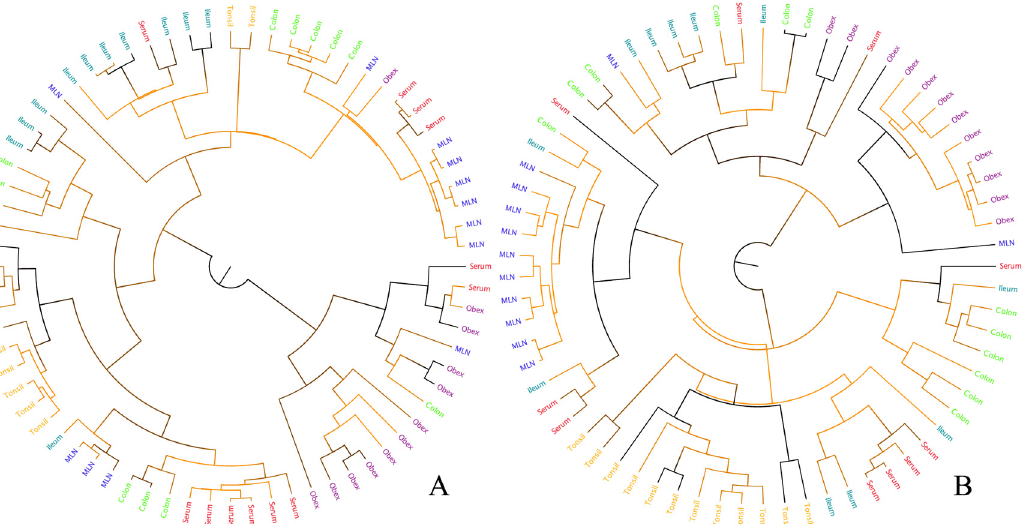
Fig 2. Example phylogenetic tree based on E2 (A) and NS5B (B) gene fragment alignment for PI8. See S2 (E2) and S3 (NS5B) Figs for all other trees. Branches are shaded according to their posterior probability (0 = orange, 1 = black) and the tip labels are coloured according to their tissue of origin (tonsil = yellow, colon = green, MLN = blue, obex = purple, serum = orange, ileum = teal).